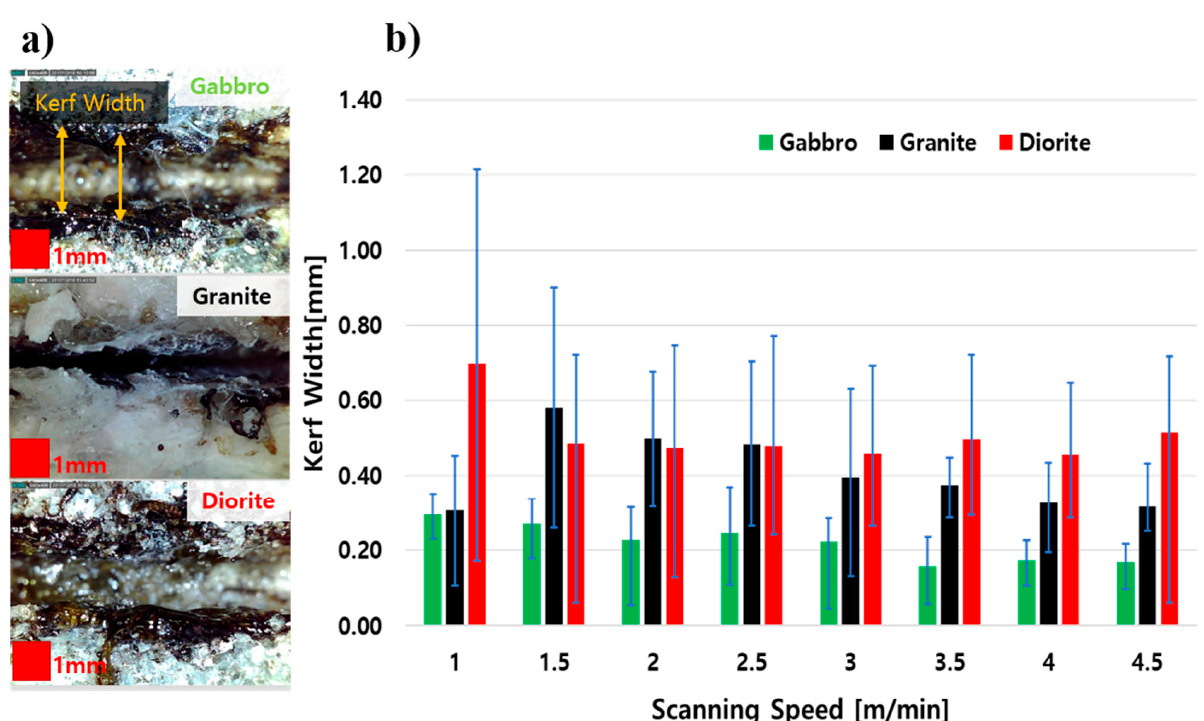
Figure 3. ( a ) The kerf width observation and ( b ) the correlation between kerf width and the scanning speeds of rocks. A one-way analysis of variance (ANOVA) was calculated for the kerf width of each rock specimen at different scanning speeds, as shown in Table 3. The analyses were significant, F (2, 21) = 27.41, p = 0.000001398. In this case, the kerf width of each rock specimen had a significant difference related to their scanning speeds. Table 3. Statistical analyses for kerf width of each rock specimen related to different scanning speeds. Descriptive